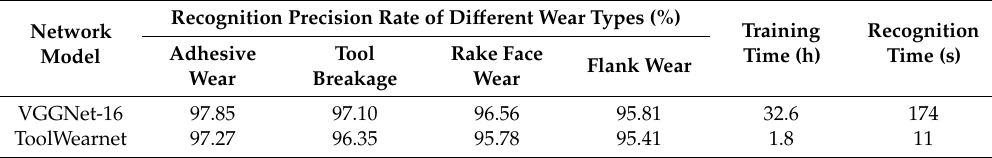
Table 7. The comparison of the recognition precision rate, training time, and recognition time of the two models.